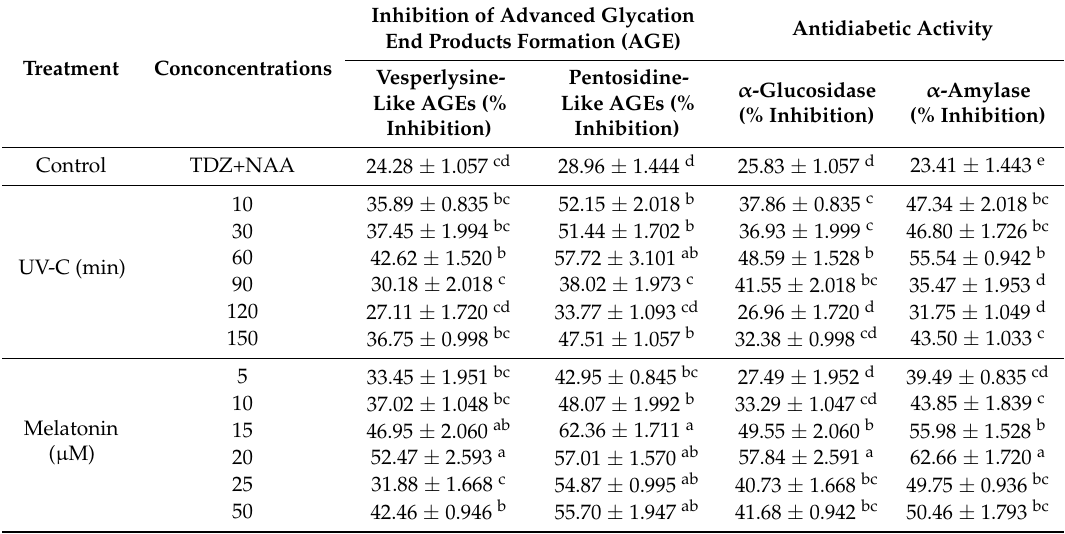
Table 1. Influence of elicitors on anti-AGEs formation and antidiabetic potential of L. sativum calli extracts. Columns with similar alphabets (letters a–e) are not significantly different ( p <